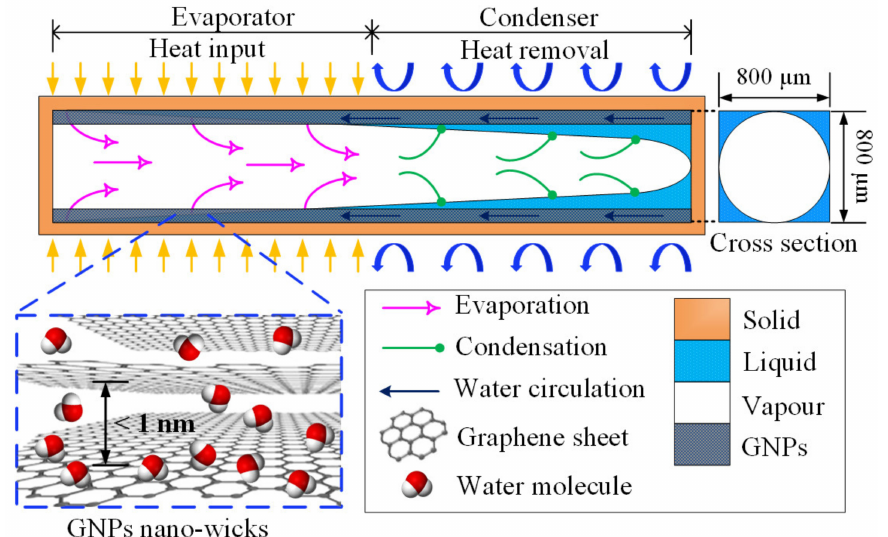
Figure 1. Schematic of working mechanism of a micro heat pipe with GNP nano-wicks. The inset illustrates the ultrafast transport of water molecules in the GNP